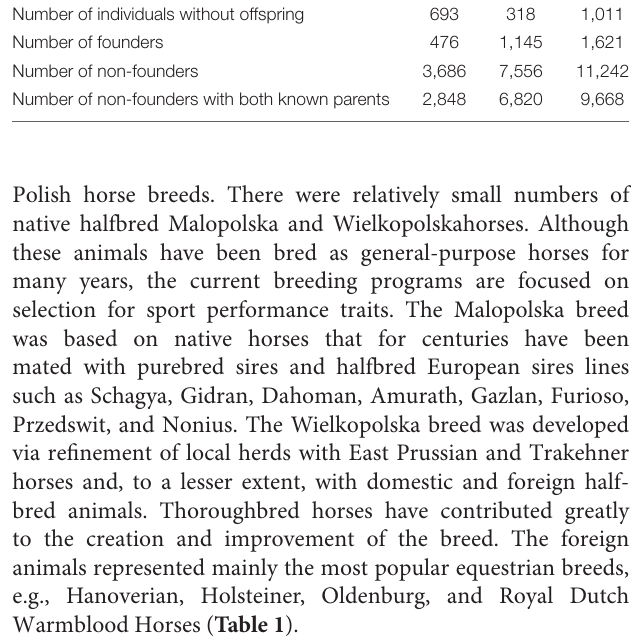
Frontiers in Genetics |